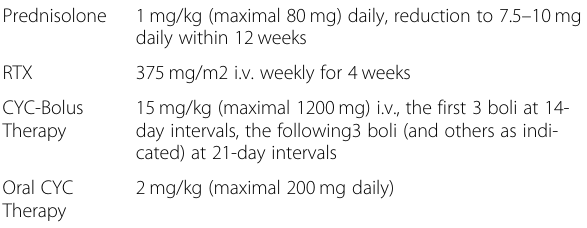
Immunosuppressive Therapy in Initial Manifestations which impair Organ Function or are Life-threatening, or in Major Recurrences of an AAV [24, 56, 64]